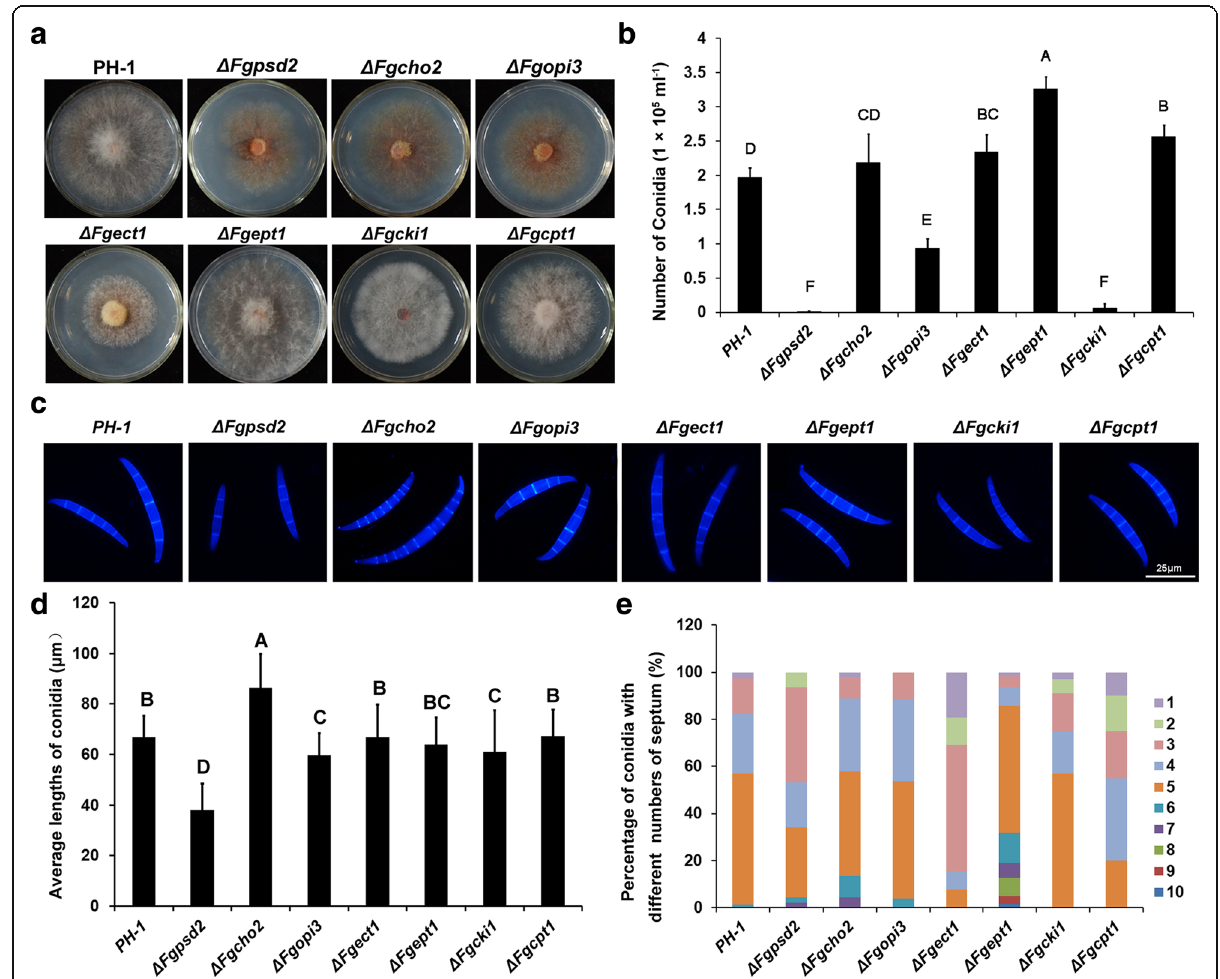
Fig. 3 Phospholipid biosynthetic genes are involved in conidiation. a Radial growth of the wild-type strain and deletion mutants on the conidiation-inducing medium CMC. b The number of conidia of each strain after 4 days of incubation in 100 mL of CMC medium. c Conidial morphology of the wild-type and deletion mutants. Septa were stained with calcofluor white and observed by fluorescence microscopy. Bar = 25 μ m. d Conidial length of the wild-type and deletion mutants. e Comparisons of the ratio of the different numbers of septa in conidia of the wild-type strain and deletion mutants harvested from 4-day-old CMC cultures. The vertical lines on the bars indicate the standard deviations of three repeated experiments. The values corresponding to the bars denoted with the same letter are not significantly different according to the least significant difference (LSD) test at P =